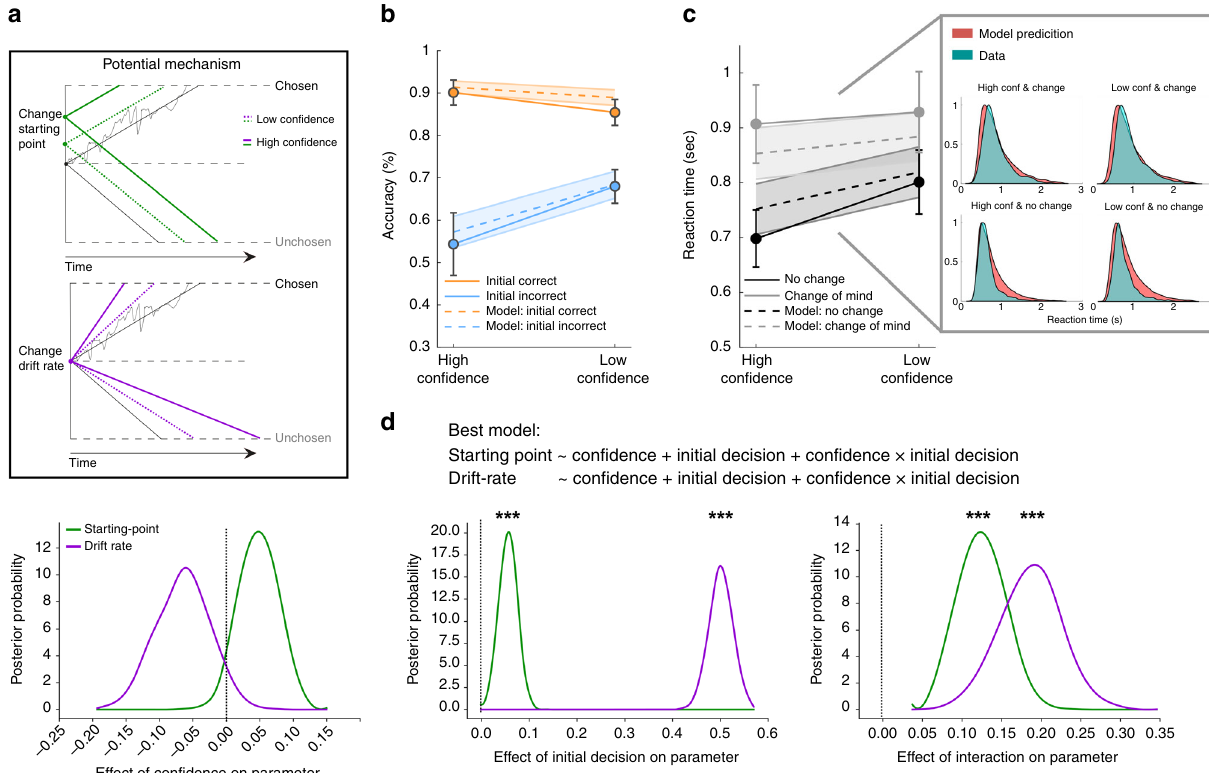
Fig. 2 Drift-diffusion modelling fi ts to the second decision (behavioural study 2, n = 23 participants). a Illustration of how con fi dence may reduce changes of mind through either a shift in starting point towards the decision bound of the initial decision (upper panel) and/or a selective increase of drift- rate for evidence supporting the initial decision (lower panel). b , c Model simulations (of the best fi tting model) reproduce behavioural patterns of accuracy and reaction times of the second decision when plotted as a function of the initial decision and initial con fi dence. Due to the task structure participants received con fi rming post-decision evidence when they were initially correct and discon fi rming post-decision evidence after initial mistakes. Model simulations are shown as dotted lines, behavioural data as solid lines. Data are presented as mean values + / − 95% con fi dence intervals. The righthand panel of ( c ) plots the full distribution of response times and model predictions for the different trial types (high con fi dence and no change of mind, low con fi dence and no change of mind, high con fi dence and change of mind, low con fi dence and change of mind). d Posterior distribution of model parameters of the best- fi tting model. The dependencies of the drift rate (purple lines) and starting point (green lines) on initial con fi dence (left panel), initial decision (middle panel) and the interaction between con fi dence × initial decision (right panel) are presented. The dotted vertical lines represent an effect of zero/no effect. Note that these dependencies are simultaneously fi tted, controlling for mutual in fl uences. Markov-Chain Monte-Carlo sampling of posterior parameter distribution: *** P (parameter > 0)>0.999. Sec =